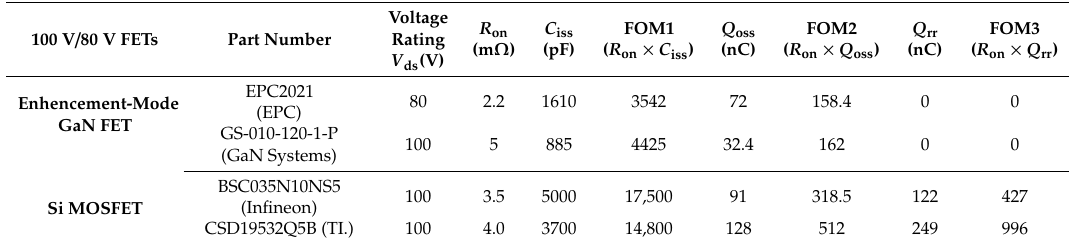
Table 2. Comparison between Si MOSFET and Gallium Nitride high electron-mobility transistors (GaN HEMT).